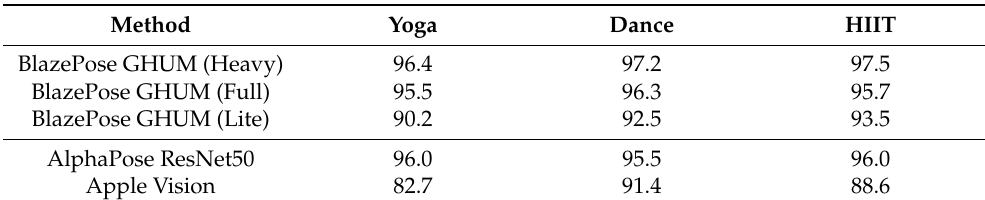
Figure 11. The results of VideoPose3D and BlazePose GHUM for the comparison of three-dimensional pose estimation performance and accuracy: seventeen double-colored circles represent the results of VideoPose3D, and seventeen red-colored circles represent that of BlazePose GHUM in white- colored circles. Table 3. The results of pose-estimation quality of BlazePose GHUM [40,41] model in MediaPipe Pose